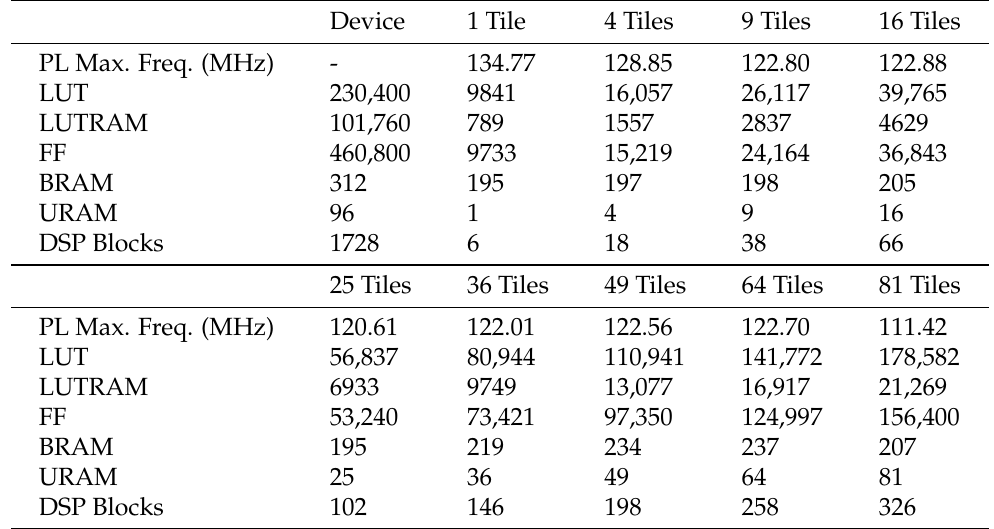
Table 3. Resources for the complete IP/CV processing chain, QVGA image, different manycore’s